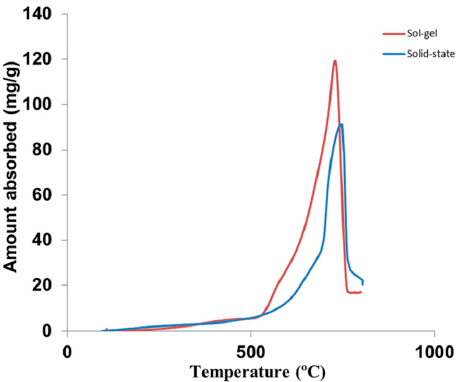
Figure 3. CO 2 absorption by Li 4 SiO 4 material in pure CO 2 with respect to temperature [25].